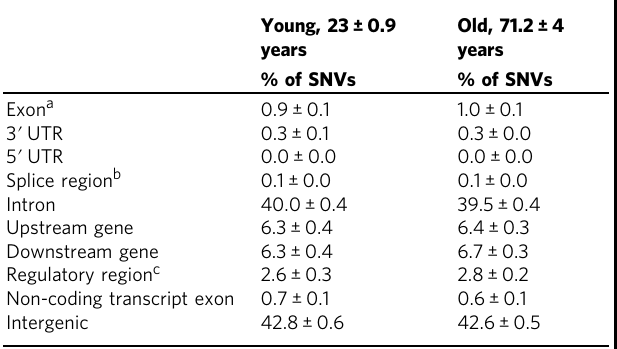
Table 1 Average distribution of the annotated variants in young and old